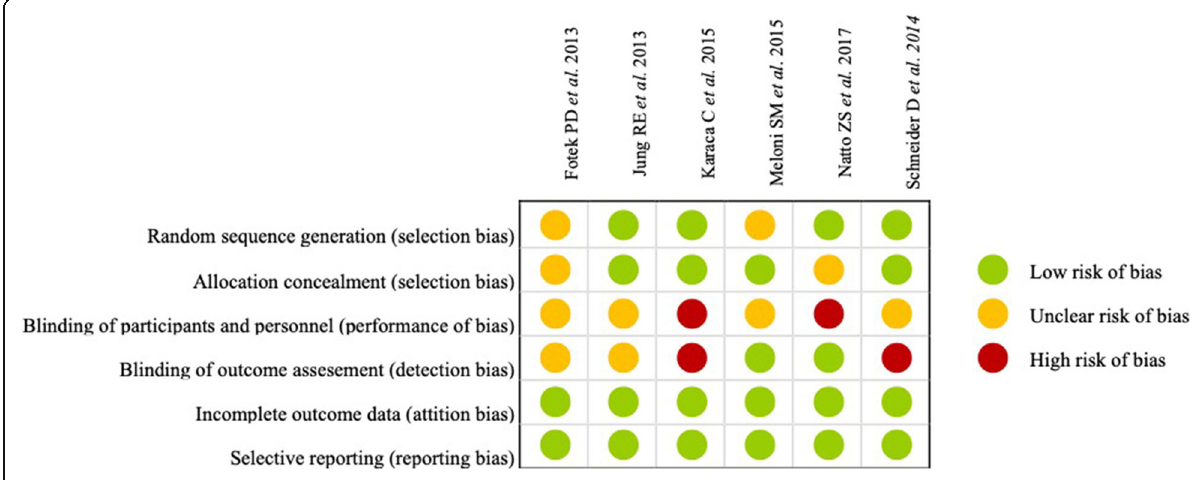
Fig. 2 Risk of bias of the included